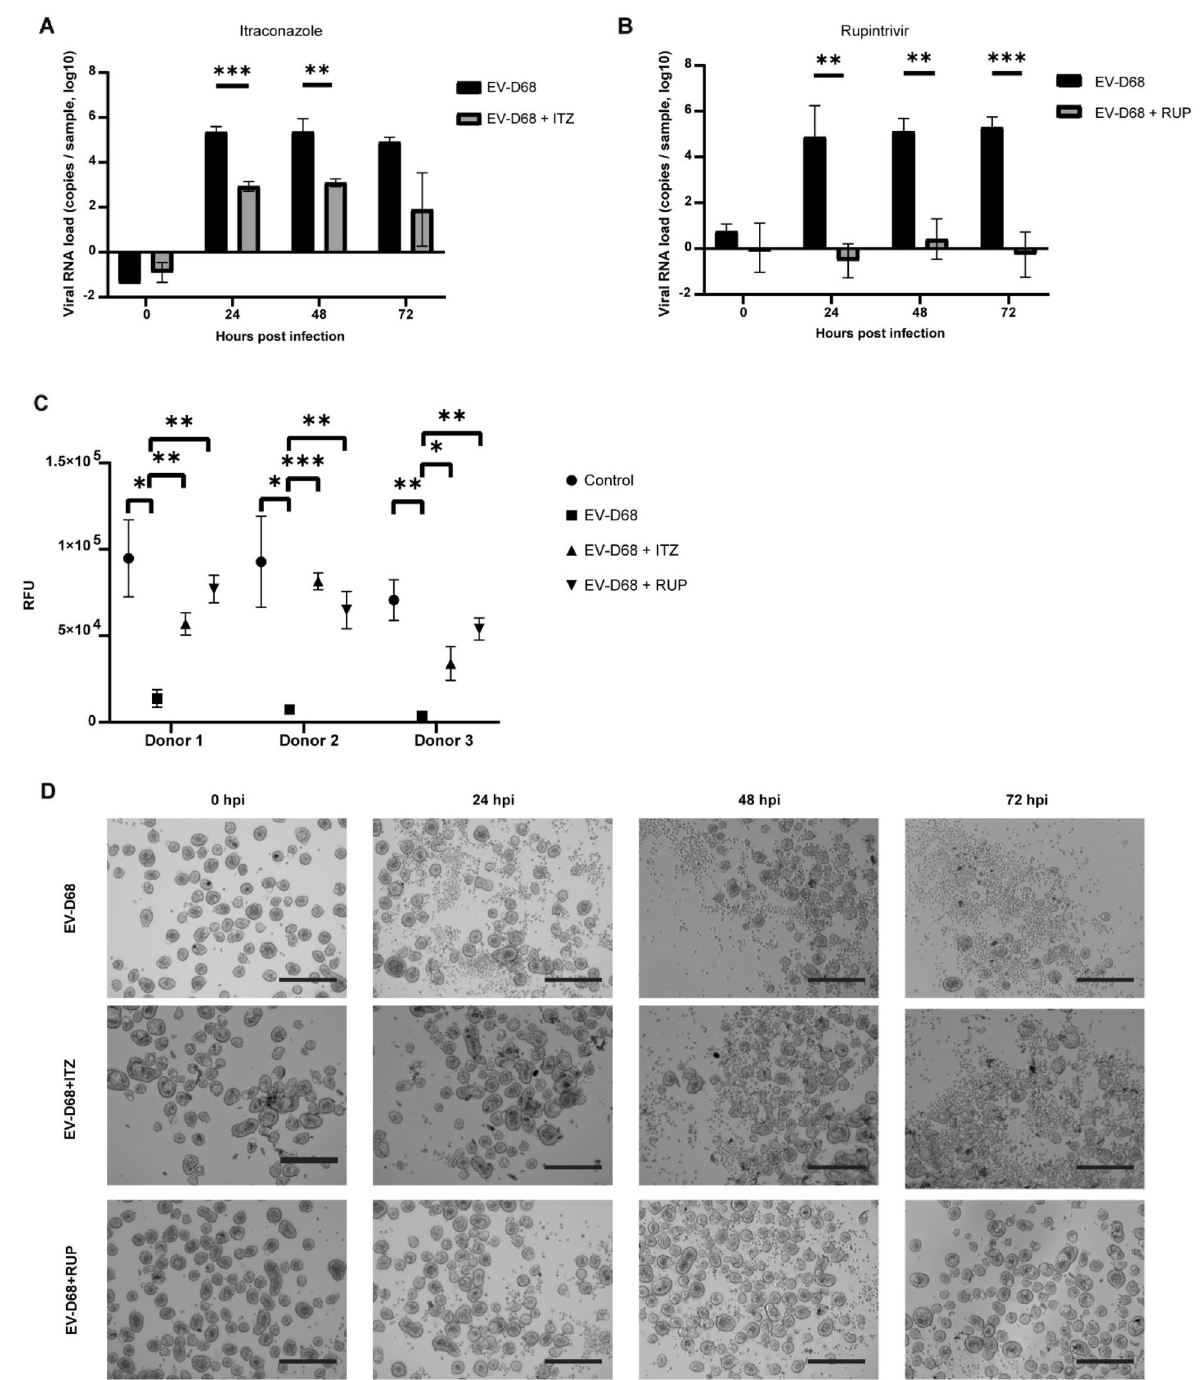
Figure 5. Ap-O AO can be utilised to study antiviral effects on EV-D68 infection. ( A ) Viral load of EV-D68 detected by qPCR in the supernatant in the presence and absence of ITZ. Points represent mean values. Error bars represent the SD. Double asterisks indicate p < 0.01 and three asterisks p < 0.001. (n = 3). ( B ) Viral load of EV-D68 detected by qPCR in the supernatant in the presence and absence of RUP. Points represent mean values. Error bars represent the SD. Double asterisks indicate p < 0.01 and three asterisks p < 0.001. (n = 3). ( C ) Relative Fluorescent Units (RFU) measured at 72 hpi indicating changes in viability of Ap-O AO following infection with EV-D68 in the presence or absence of ITZ and RUP. Single points represent the mean with SEM. Single asterisks indicate p < 0.05, double asterisks p < 0.01 and three asterisks p < 0.001. (n = 3). ( D ) Representative images (Donor 2) showcasing the CPE observed in Ap-O AO following infection with EV-D68 without antiviral treatment (top row) and with addition of ITZ (middle row) or RUP (bottom row). (scale bars = 300